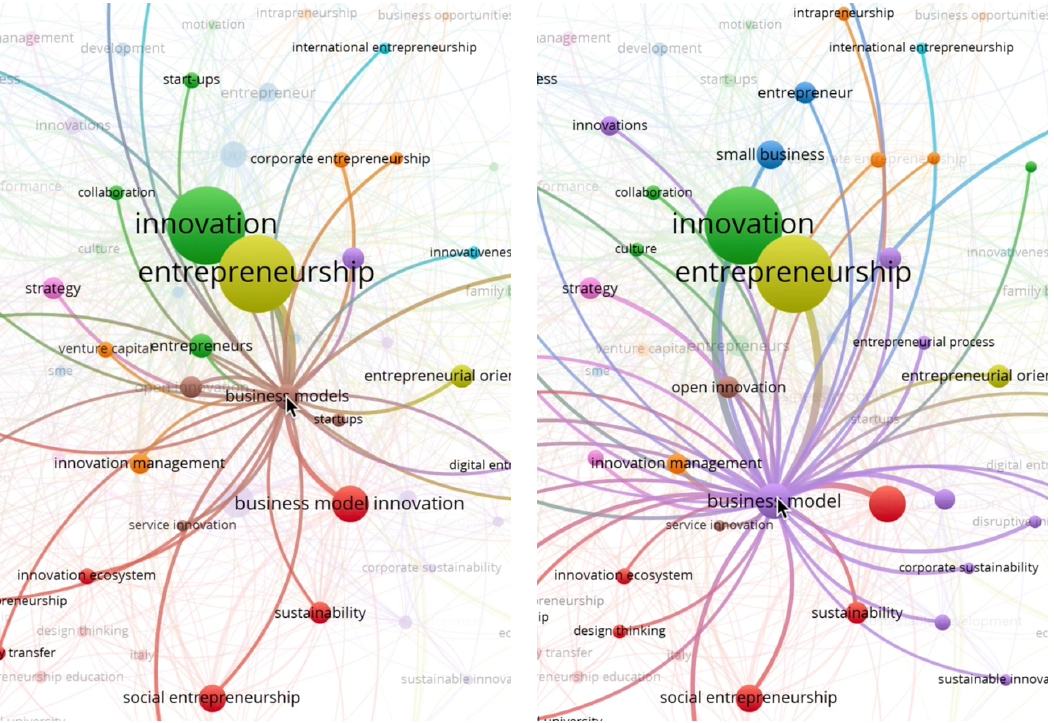
Fig. 4. Showing the keywords “business model” and “business